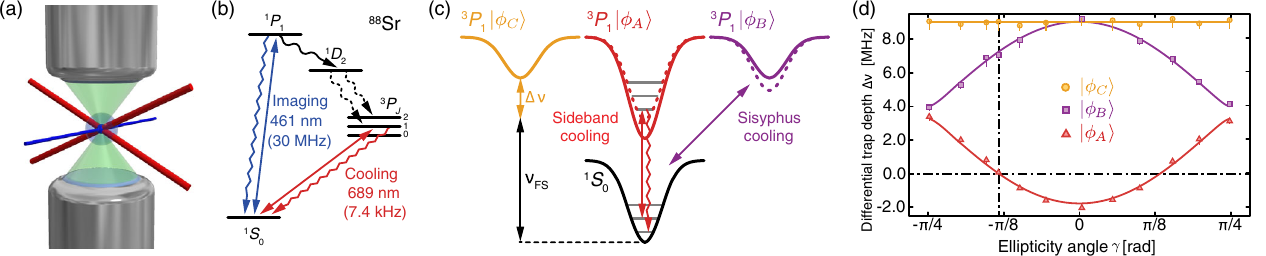
FIG. 1. Tweezer trapping of strontium. (a),(b) A single strontium atom is trapped in an optical tweezer (propagating upward along the ˆ z direction) created by focusing a 515.2-nm laser beam through a microscope objective with NA ¼ 0 . 5 (bottom objective). The atom is imaged by scattering photons on the broad blue transition (461 nm) from a transverse imaging beam, while simultaneously being cooled on the narrow red transition (689 nm) with three red MOT beams (one red beam, overlapped with the imaging beam, is not shown). Fluorescence photons are collected with the bottom objective, while the top objective is mainly used for monitoring the tweezer light. (c) The applied narrow-line cooling mechanisms, sideband and Sisyphus cooling, depend crucially on the relative trapping potential between ground and three excited sublevels of 3 P 1 . In a linearly polarized tweezer, these sublevels can be labeled with angular − 1 , 0, 1. In elliptical light, rotational symmetry is broken and the sublevels are generally momentum projection quantum numbers m j ¼ not angular momentum eigenstates anymore. Hence, we label these states with a different notation: j ϕ , j ϕ , j ϕ (from left to right). C i A i B i Two of the states shift as a function of ellipticity (dashed compared to solid lines). (d) Differential trap depth (proportional to differential polarizability) of the three sublevels of 3 P 1 as a function of tweezer ellipticity angle γ , measured with excitation-depletion spectroscopy (Appendix B and Sec. VI). The tweezer polarization is given by ⃗ ϵ ð γ Þ ¼ cos ð γ Þ ˆ x þ i sin ð γ Þ ˆ y . The solid lines are a fit to the eigenvalues of the ac Stark Hamiltonian (Appendix B). At the magic ellipticity angle ˜ γ ¼ (cid:2) 24 °, the differential polarizability between 1 S 0 and 3 P 1 j ϕ A i vanishes (dash-dotted line). The other two sublevels experience a weaker trapping potential (positive differential trap depths) for all γ